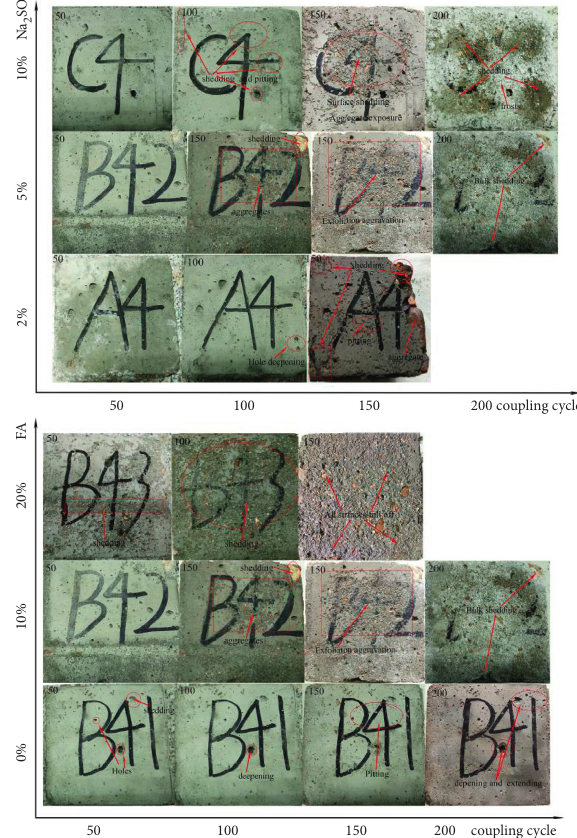
Figure 2: Morphology of fly ash concrete after coupling